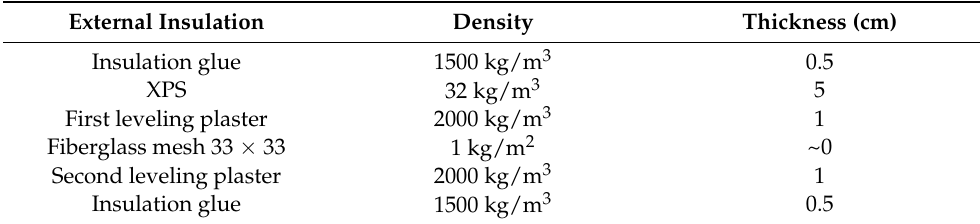
Table 1. Thickness and properties of the materials used for the